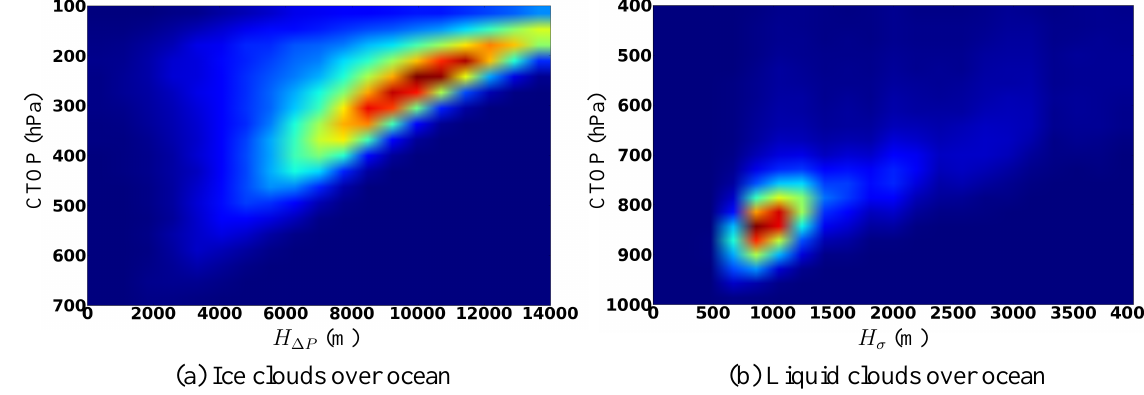
Fig. 15. POLDER-based climatology of cloud top pressure versus cloud vertical extent for selected monolayered clouds in 2008: ice clouds (a) and liquid clouds (b) over ocean. To be compared with the left-hand panels of Fig. 4.